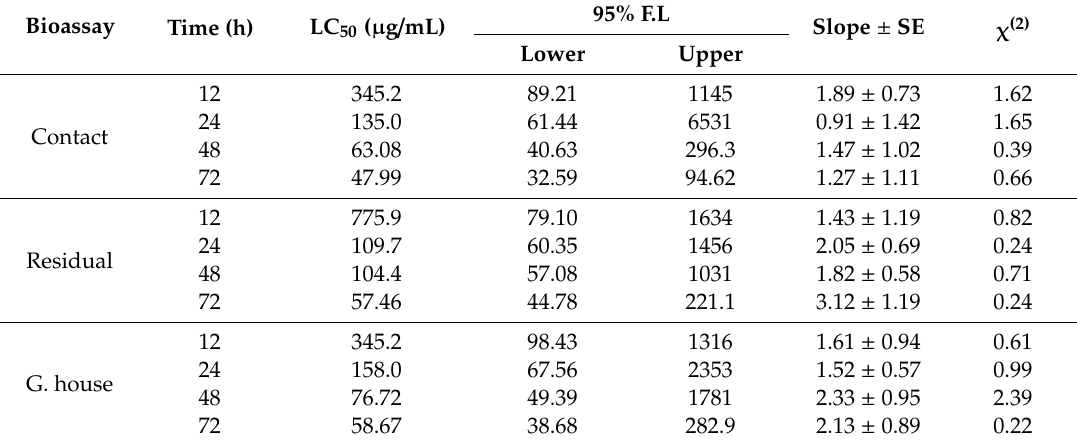
Table 6. Probit analysis of the e ff ects of fernenol on Brevicoryne brassicae .